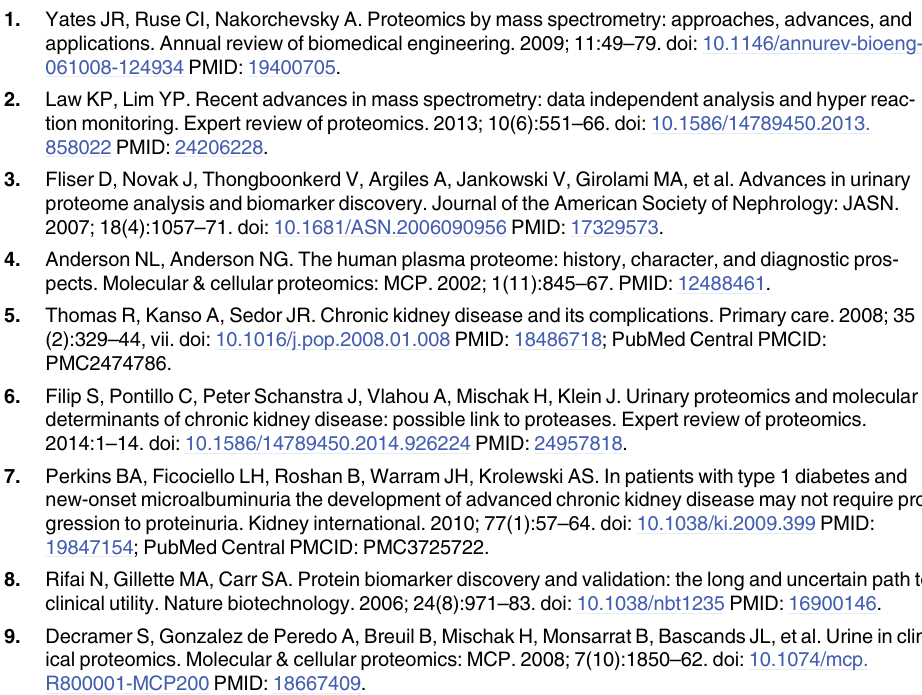
). Proteins on the Y axis 2